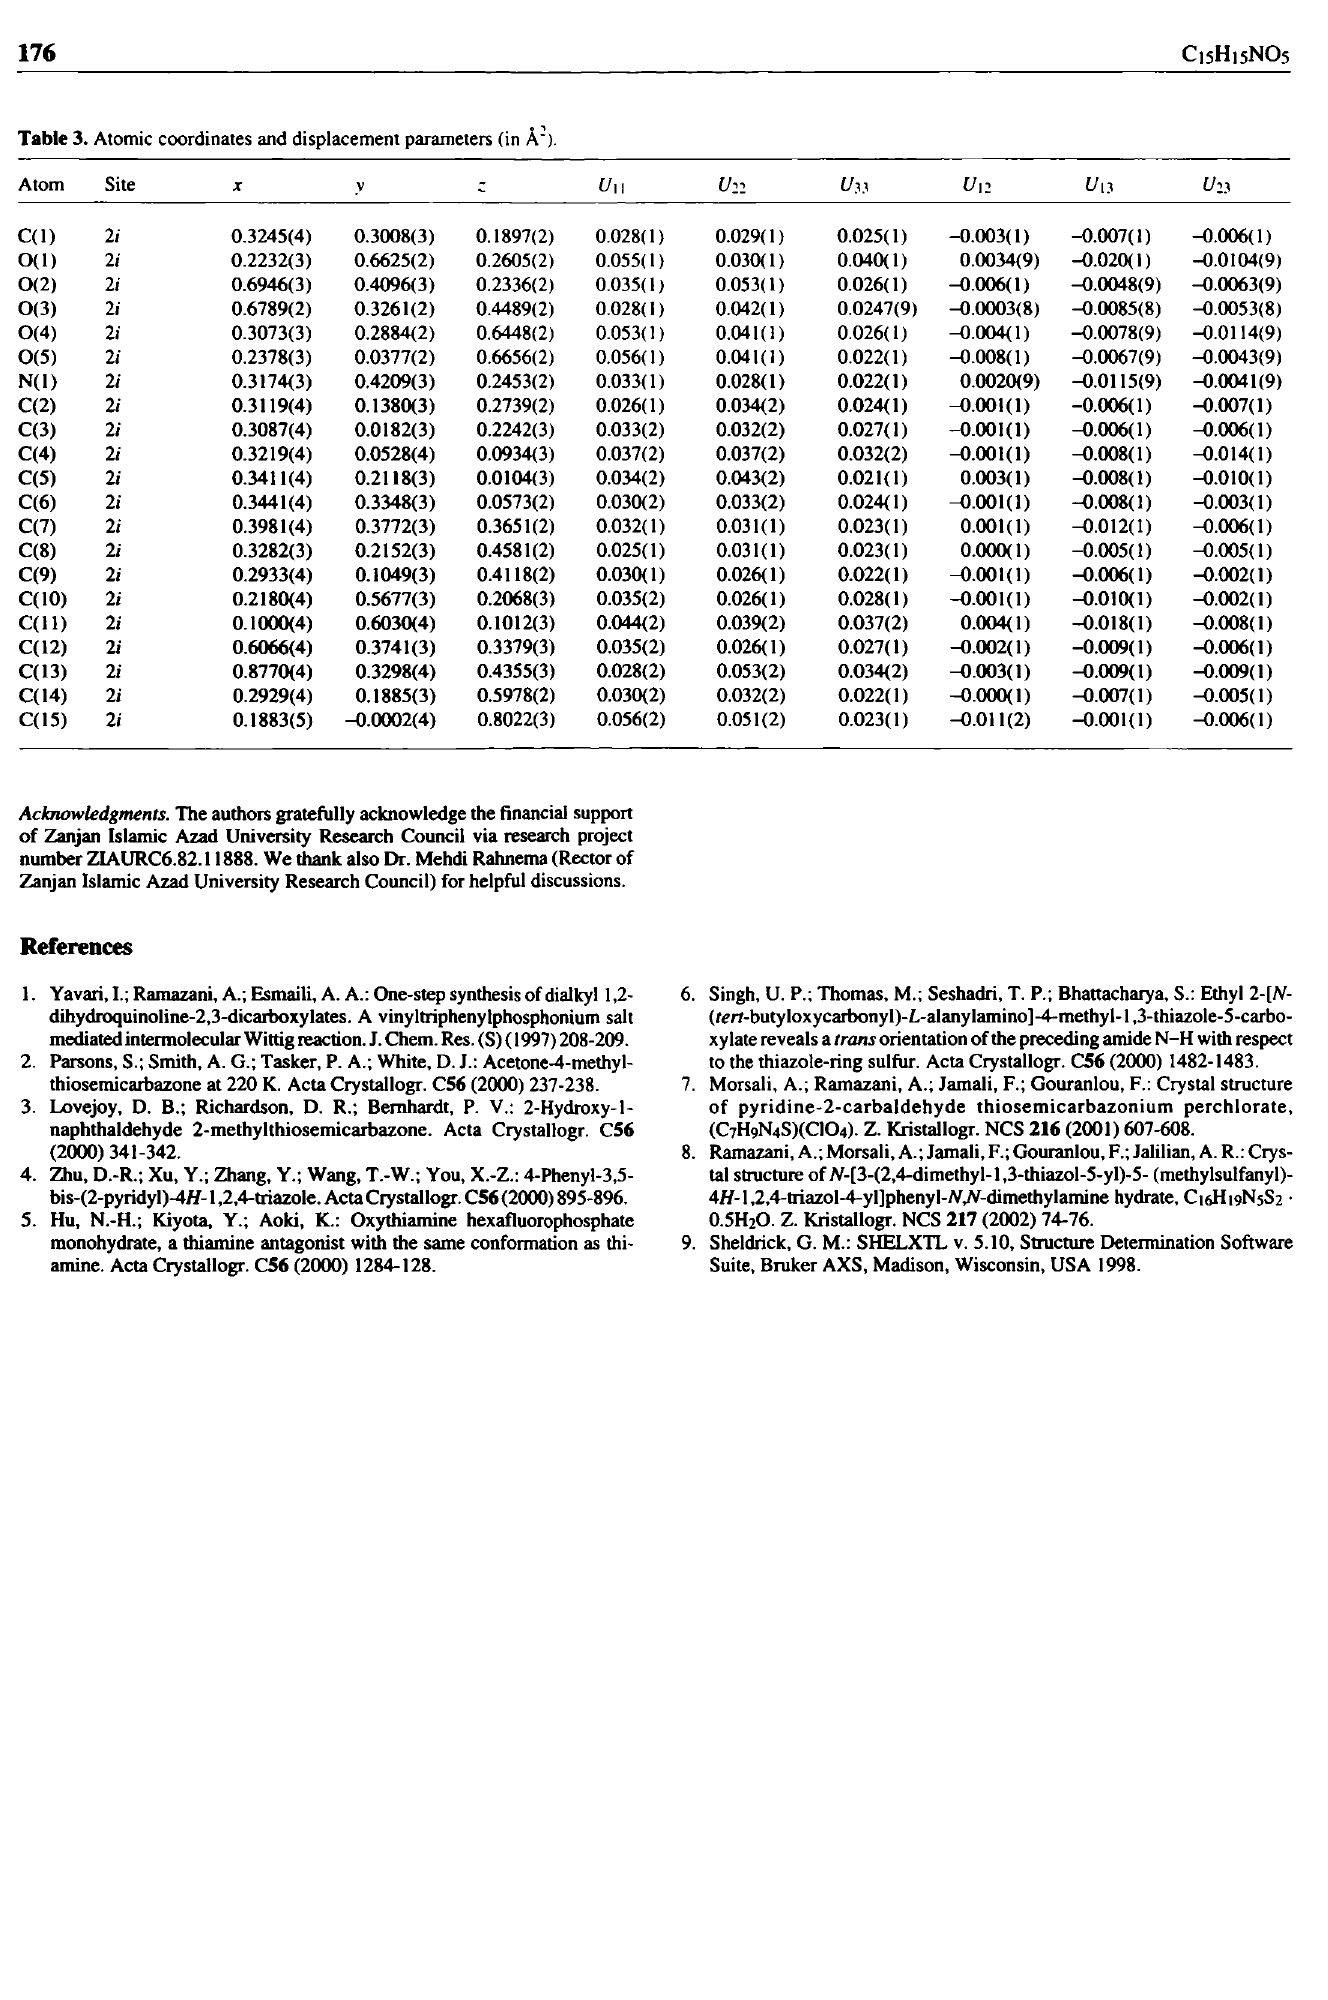
Table 3. Atomic coordinates and displacement parameters (in